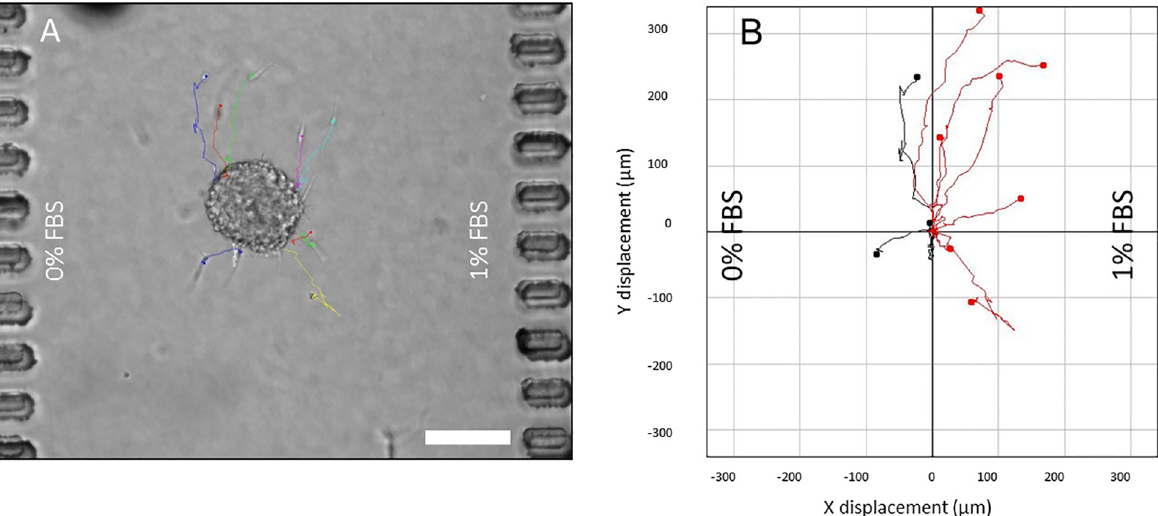
Fig 9. Chemotactic behavior of U-87MG spheroids under a chemotactic gradient. (A) Spheroid was embedded in collagen hydrogel within the central microchamber. Media supplemented with 1%FBS was perfused through one lateral microchannel whereas basal media was used in the other. Brightfield image with overlaid tracks of migrating cells after 12 hours. (B) Individual cell trajectories are plotted, showing those with a net displacement to the right in red, and those displaced to the left in black. Scale bar is 100 μ m.